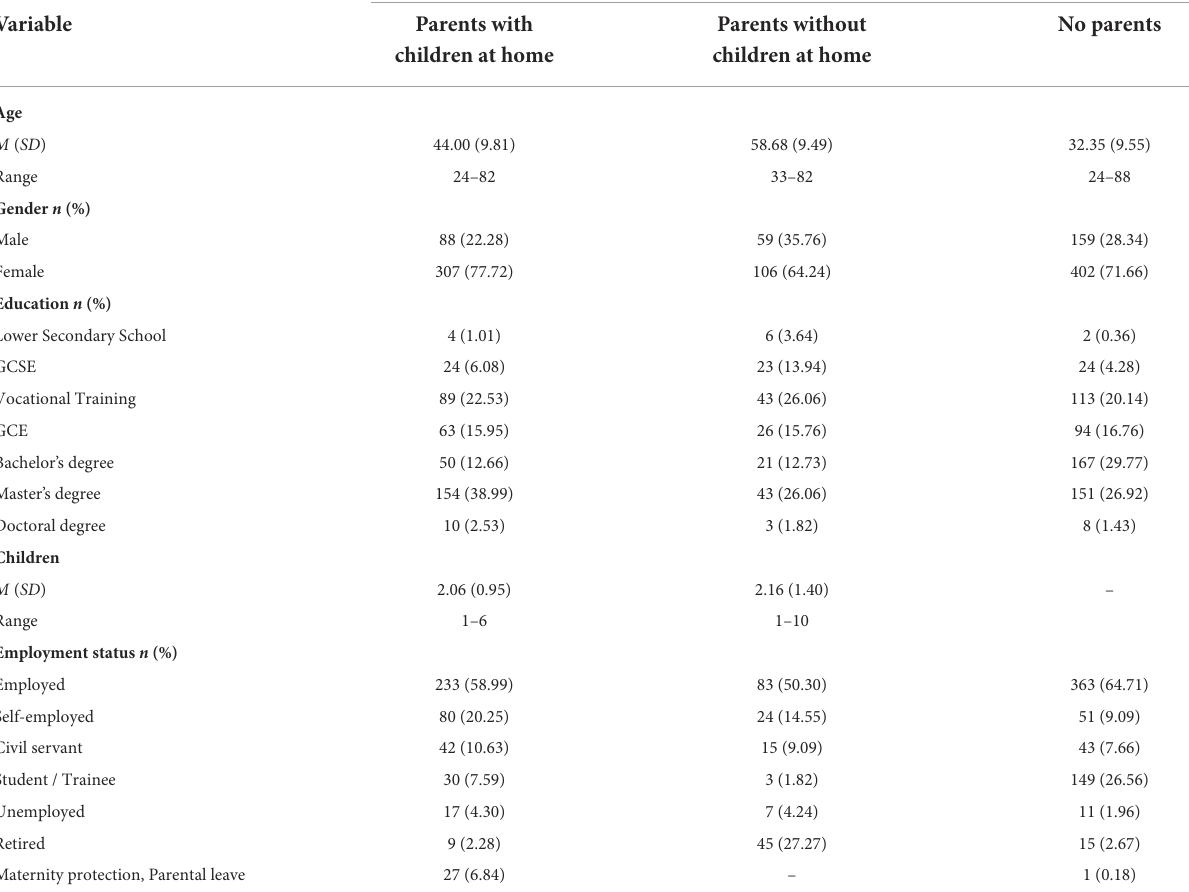
TABLE 1 Demographic characteristics of